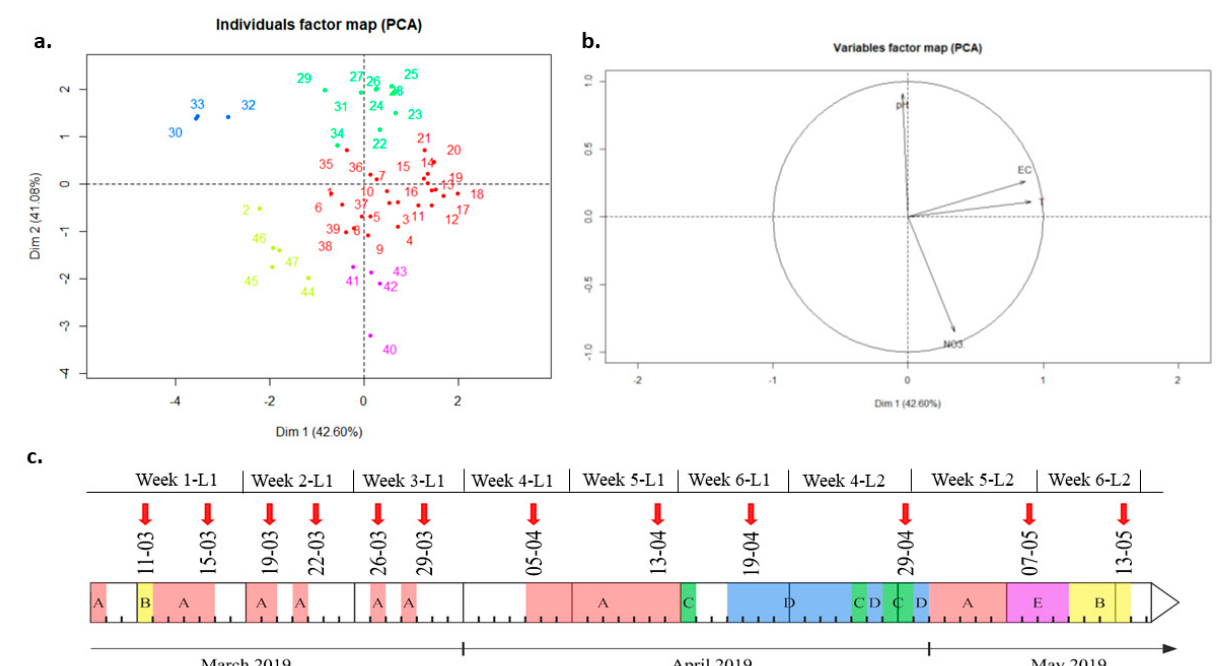
Figure 4. PCA representation ( a ) of the hierarchical clustering of sampling dates based on four water parameters (EC, pH, T, [NO3]). Dimension one represent 42.6% of the variability and distinguishes sampling dates based on EC and T (see variables factor map in ( b )) while dimension two represents 47.08% of the variability and separates the samples based on pH and [NO3] (see variables factor map in ( b )). Once put into chronological order, the five physicochemical groups are represented on the timeline ( c ). White intervals on the timeline represent periods where data was lost due to probe problems. Between March 11 and April 5, the lettuce group 1 was sampled. On April 13 and April 19 the, the lettuce group 1 samples were discarded due to disease symptoms and only the sump and biofilter samples were kept. On April 29, May 5 and May 13, the lettuce group 2 was sampled. Red arrows highlight the sampling dates.